Question: In a single sentence, describe what this figure presents.
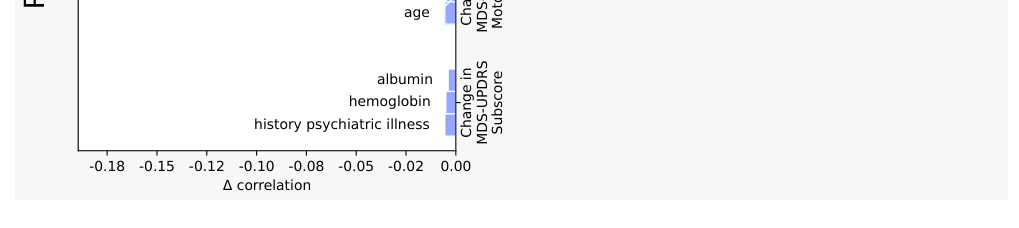
Answer: Input Sensitivity for the Neurodegeneration therapeutic Area. For each indication, three important outcomes are selected and indicate in the y-axis label. Bars indicate how much certain features indicated in the text on the plot reduce the correlation of the feature’s prediction when evaluated on the entire population of held out patients.